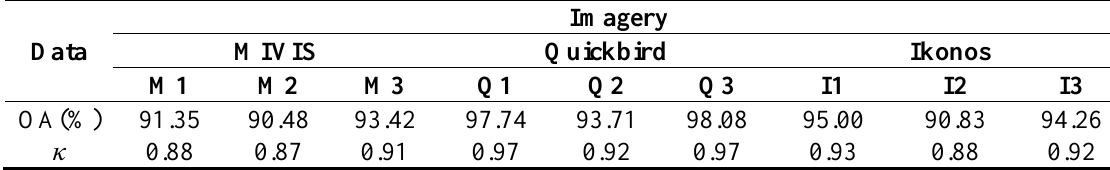
Table 3. MIVIS, Quickbird and Ikonos classifications